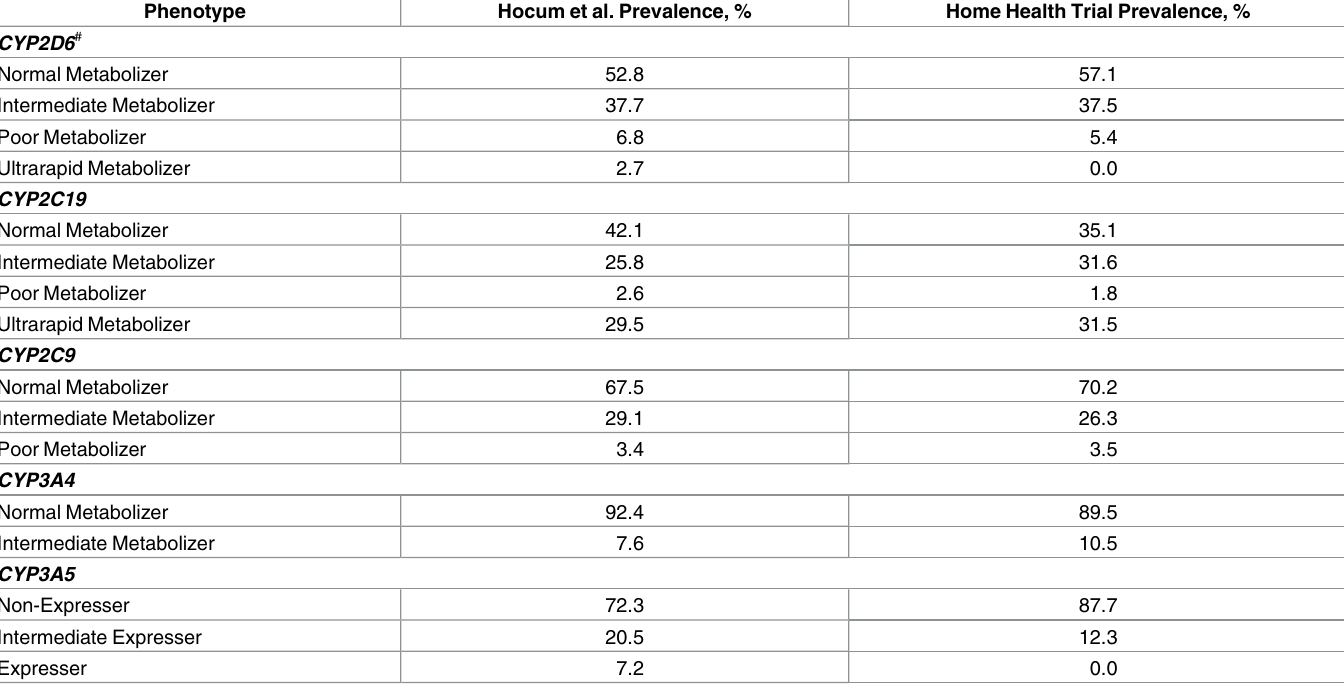
Table 5. Distribution of evaluated cytochrome P-450 (CYP) metabolic phenotypes between the Home Health Trial and another published study population